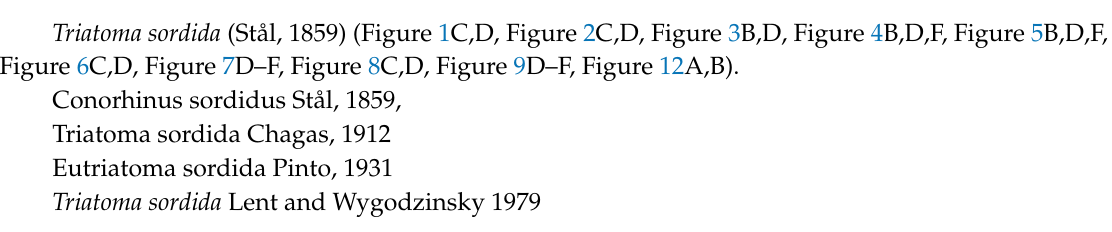
Table 4. Experimental crosses performed between T. sordida sensu stricto and T. rosai sp. nov. Experimental Crosses